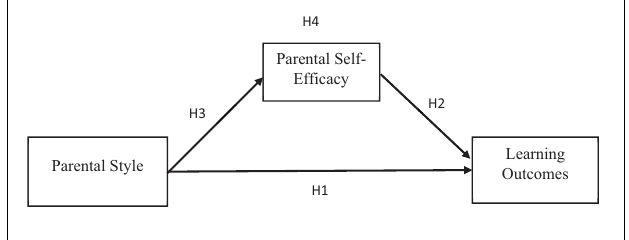
FIGURE 1 | Conceptual